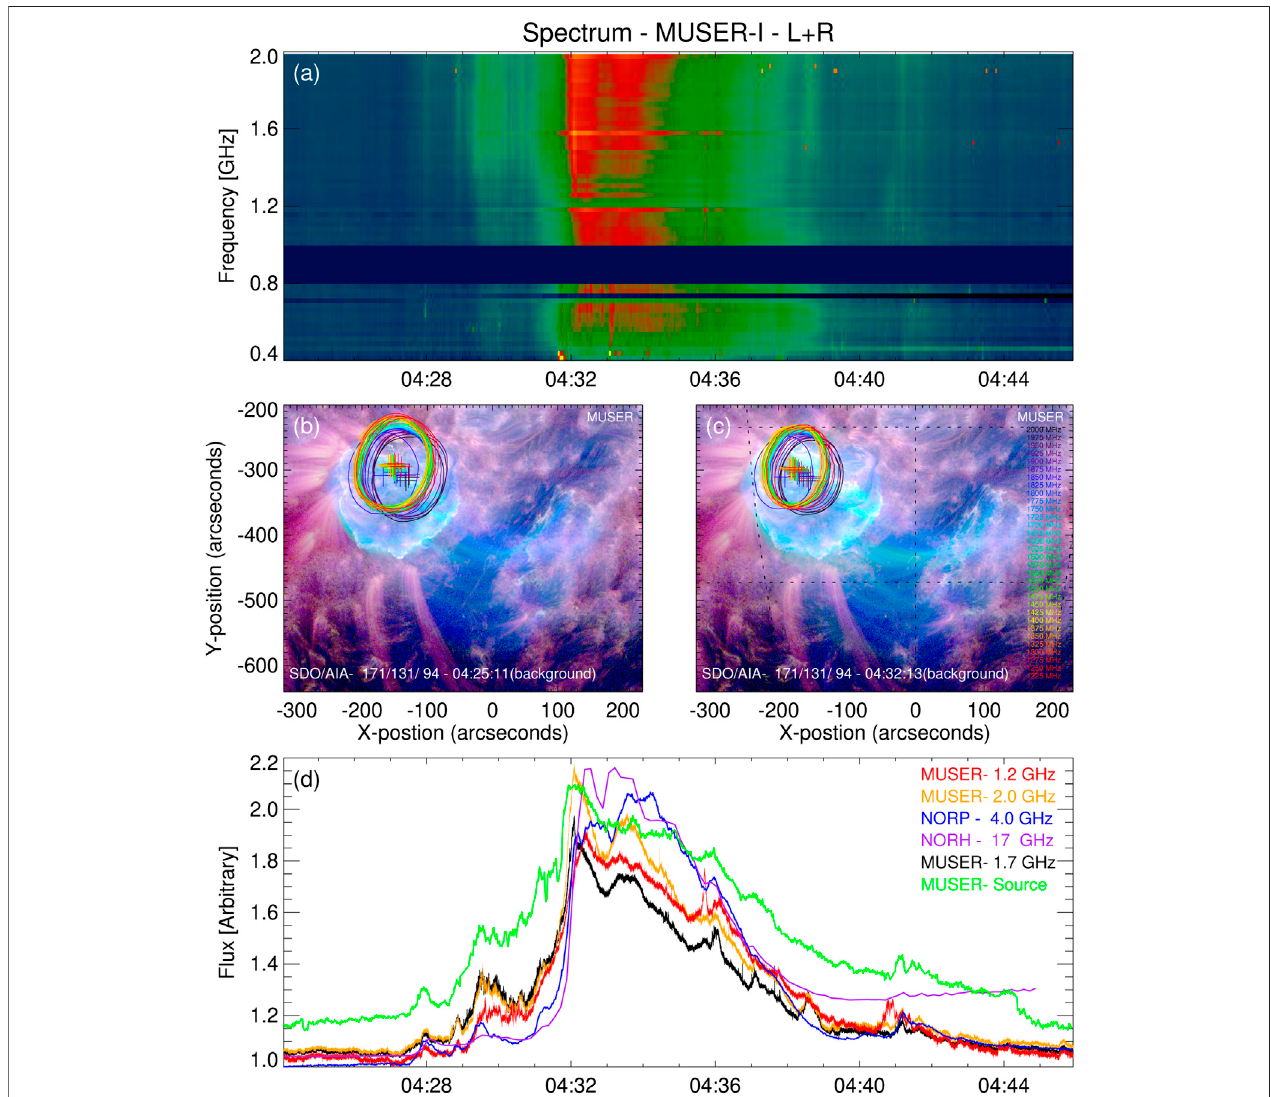
FIGURE 8 | (A) The dynamic spectrum of quasi-periodic pulsations overlaid on type IV solar radio continuum was recorded by MUSER-I in a time range of 04: 25 – 04:45UTandafrequencyrangeof1.2 – 2.0 GHz. (B) and (C) Imagesoftheradiosourcewitha50%intensitylevelobservedatmultifrequenciesfrom1.2 GHz(red)to 2.0 GHz(black),overlaidontheAIAimagesofthreecombinedwavelengthsatthestart(04:25UT)andpeak(04:32UT)timeoftheradioburst.Theradiosourcecentroids were marked by the plus signs. (D) The radio fl ux curves from NoRP, the spectrum of MUSER and the intensity of radio source from MUSER imaging